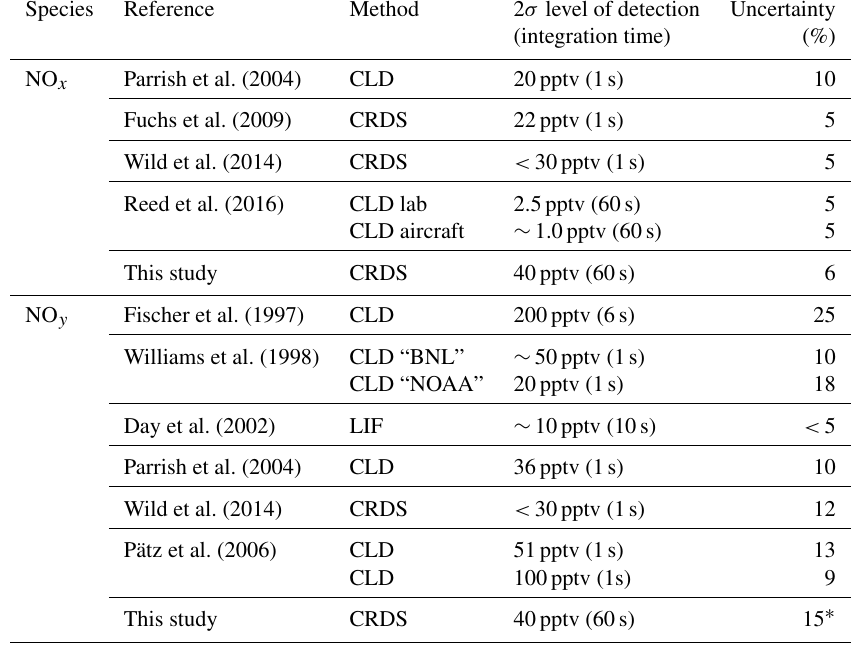
Table 1. Comparison of NO x and/or NO y